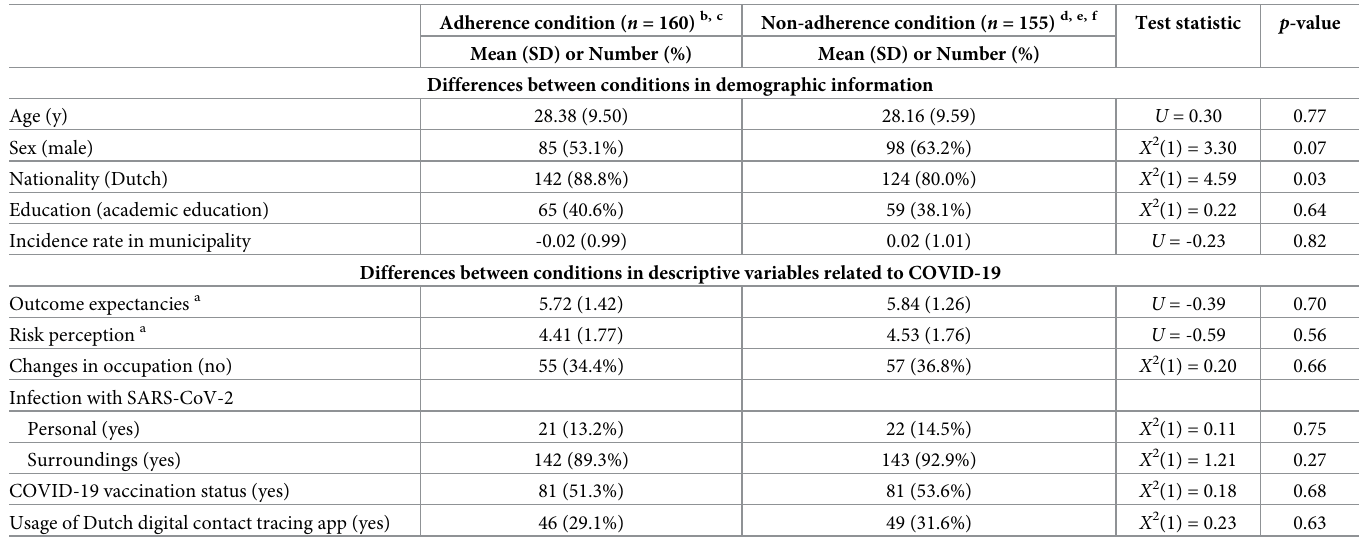
Table 3. Descriptive statistics per condition ( n = 315), test statistic and p -value refer to non-parametric Mann-Whitney tests and Pearson chi-square